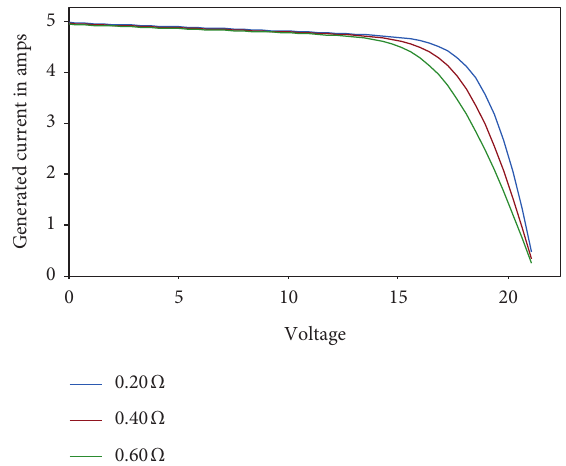
Figure 10: Simulated I-V plot of varying R